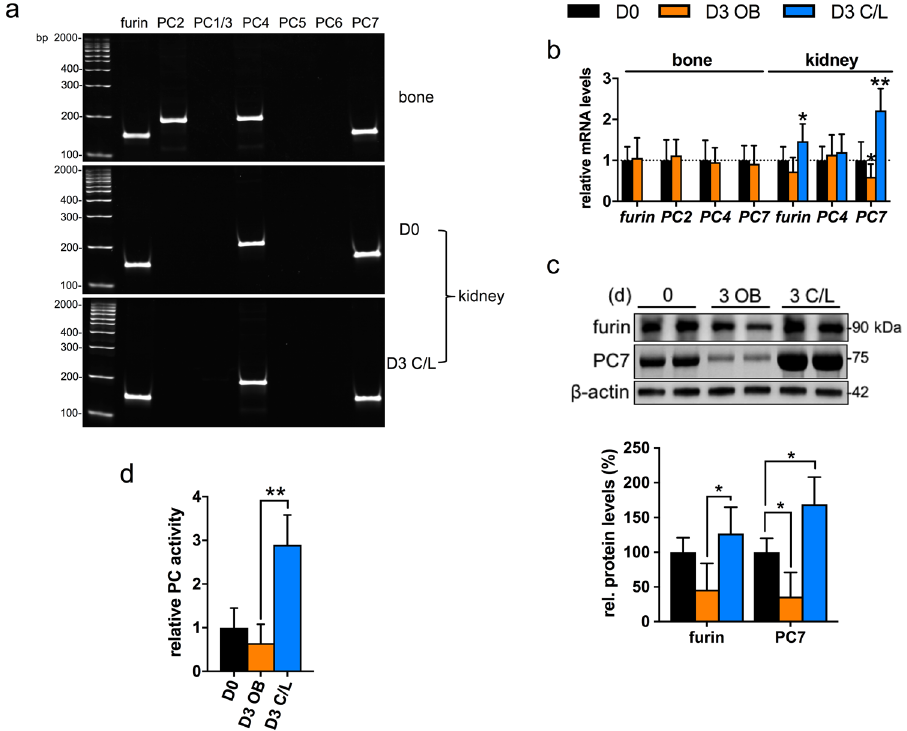
Figure 4. UUO induces changes in proprotein convertase expression. ( a ) RT-PCR detection of proprotein convertase (PC) transcripts expressed in mouse hind limb bone and kidney (D0 and D3 post-UUO). ( b ) qRT- PCR analysis of proprotein convertases (furin, PC2, PC4, PC7) gene expression in both hind limb bone (D0, D3) and kidney tissue at D0 and D3 (OB and C/L). Results are expressed relative to transcript levels at D0 (n = 4 mice for each group). ( c ) Representative Western blot analysis of furin and PC7 levels in kidney homogenates. β -tubulin was used as a loading control. Quantification of the proproprotein convertase/ β -actin signal ratios normalised ( = 1.0) to control D0 levels (n = 4 mice for each group). ( d ) Relative proprotein convertase enzyme activity in D3 OB and D3 C/L kidney homogenates normalised to D0 controls (n = 4 mice for each group). Data are shown as mean ± SD. * P < 0.05; ** P < 0.01. P-values were determined by one-way ANOVA with Holm- Sidak multiple comparisons